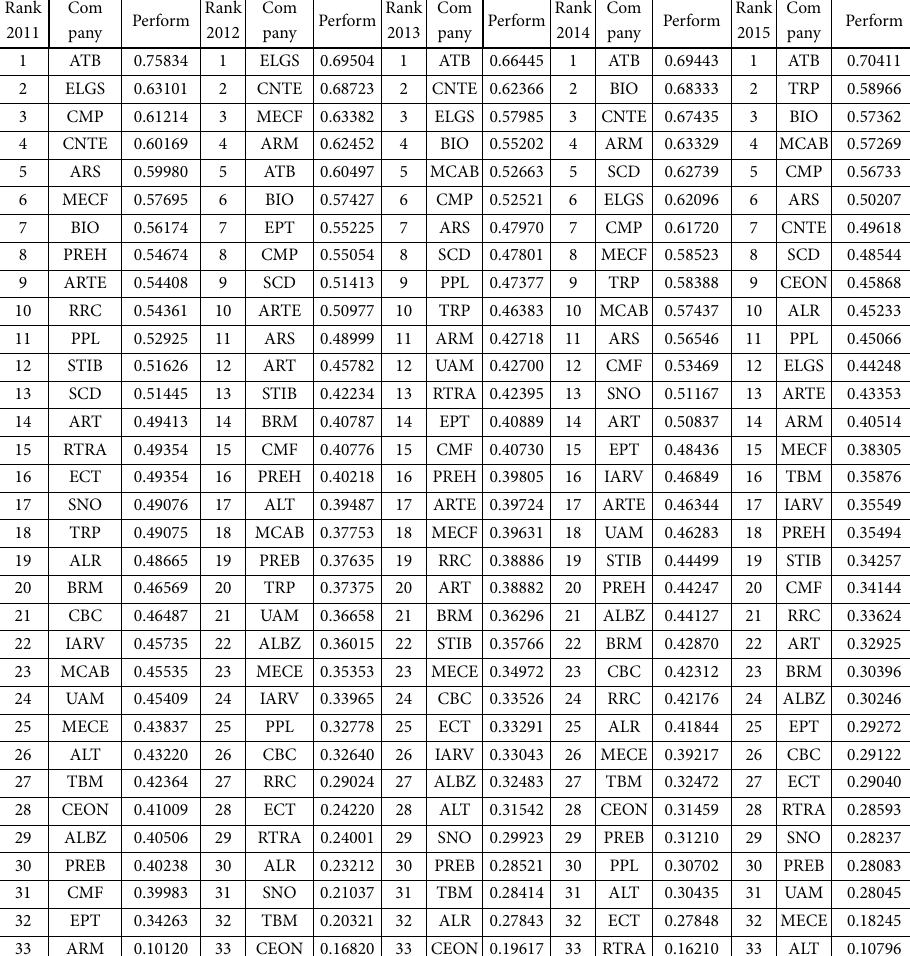
Table 12. Final ranking of the companies in relation to all indicators (FP and